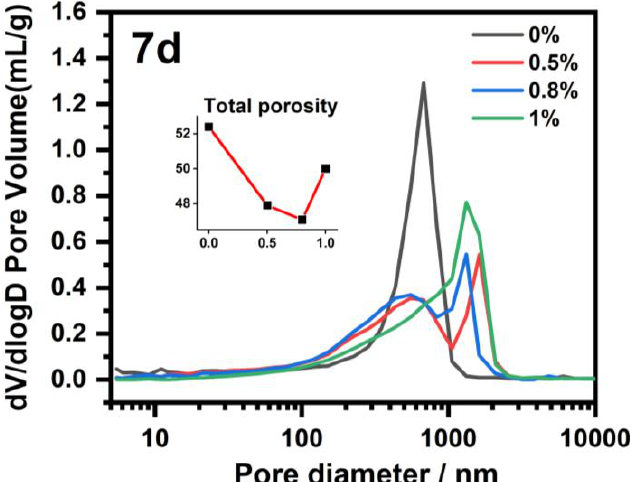
Figure 15. Pore size distribution measurement of NHL pastes with varying IBMA content by MIP testing.